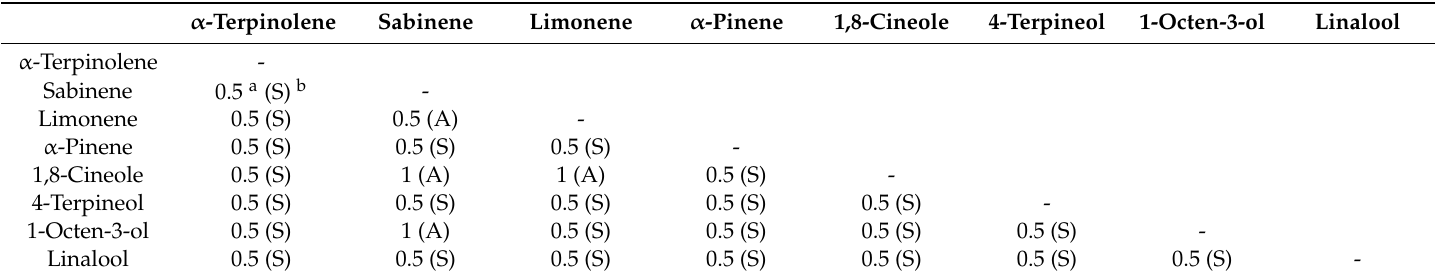
Table 4. Interactive e ff ects of individual compounds on the insecticidal